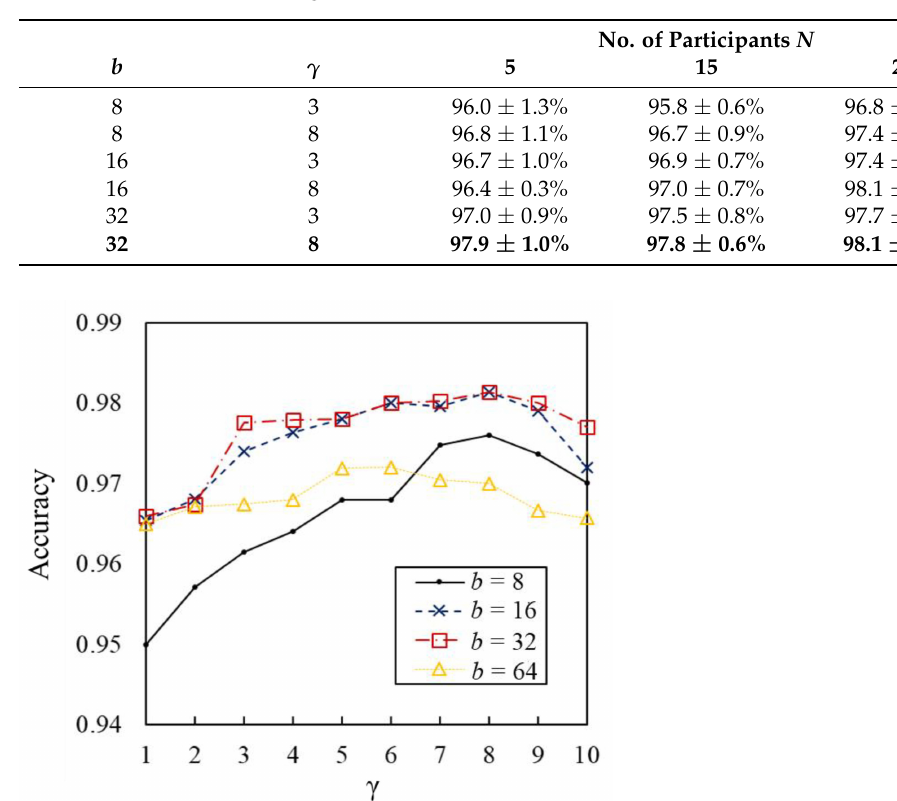
Table 2. Results for WT Scalogram.